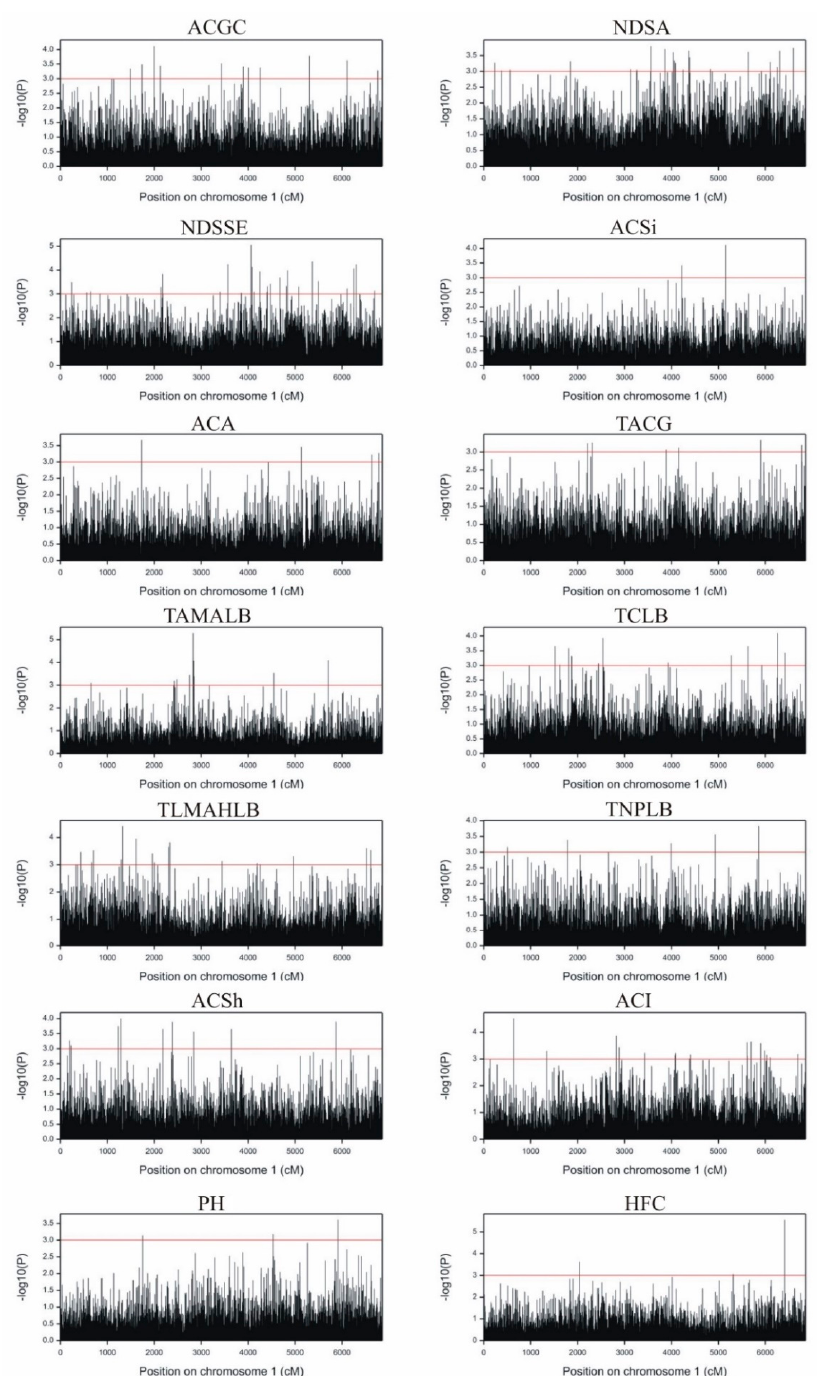
Figure 4. Manhattan plots for all 14 observed traits of maize: ACGC-anthocyanin coloration of cob glumes, NDSA—number of days from sowing to anthesis, NDSSE—number of days from sowing to silk emergence, ACSi-anthocyanin coloration of silks, ACA-anthocyanin coloration of anthers, TACG-tassel: anthocyanin coloration at glume base, TAMALB—tassel: angle between the axis and lateral branches, TCLB—tassel: curvature of lateral branches, TLMAHLB—tassell: length of the main axis above the highest lateral branch, TNPLB—tassel: number of primary lateral branches, ACSh—anthocyanin coloration of the sheath, ACI—anthocyanin coloration of internodes, PH—plant height, HFC—height of the first